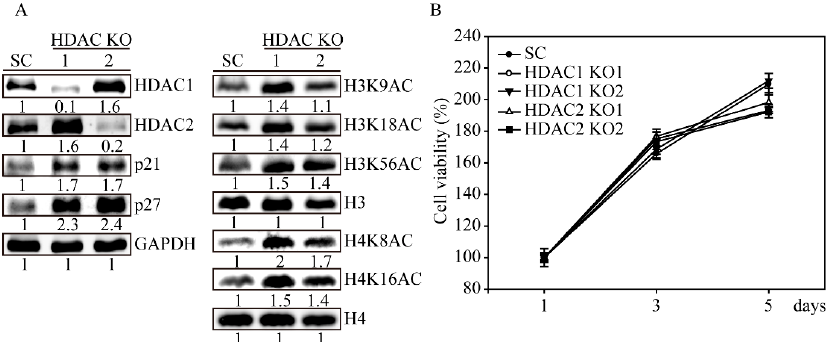
Figure 5. HDAC1 and HDAC2 KO SW579 cells induced H3 and H4 acetylation and cell arrest proteins. ( A ) Immunoblot analysis of gene expression in HDAC1 and HDAC2 KO SW579 cells. The cell